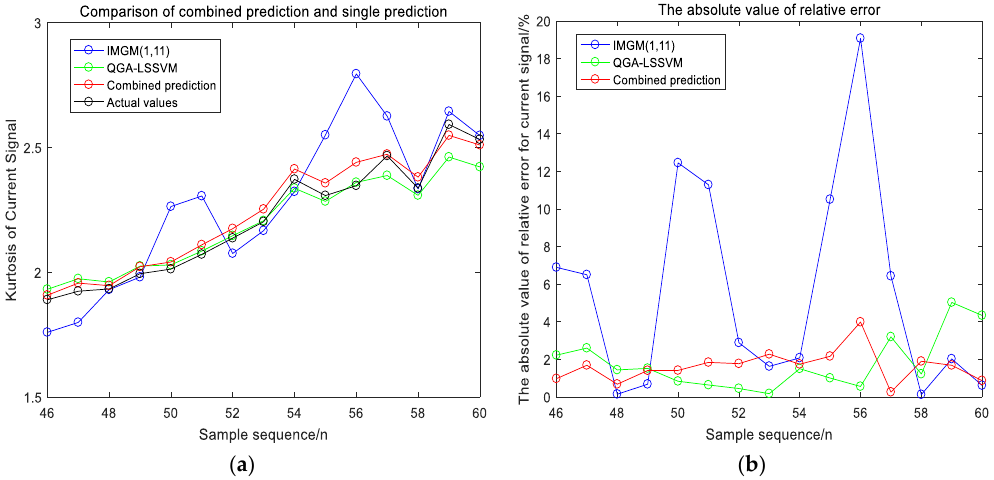
Figure 7. Comparison of the combined forecasting model and the single forecasting models for current signal. ( a ) The prediction result from the 46th points to the 60th points; ( b ) the absolute value of relative error.